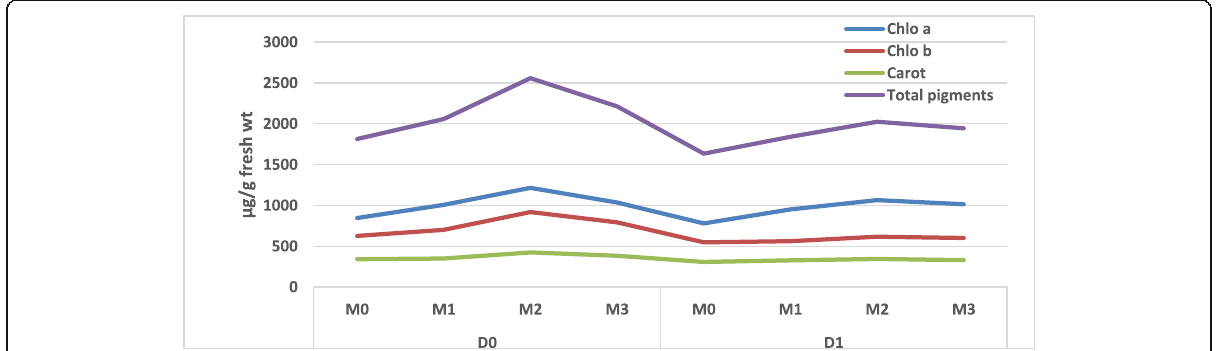
Fig. 1 Effect of melatonin (0, 50, 100, and 150 mM) on photosynthetic pigments ( μ g/g fresh wt.) of M. oleifera plants subjected to drought stress (normal irrigation and skipping two irrigation times)